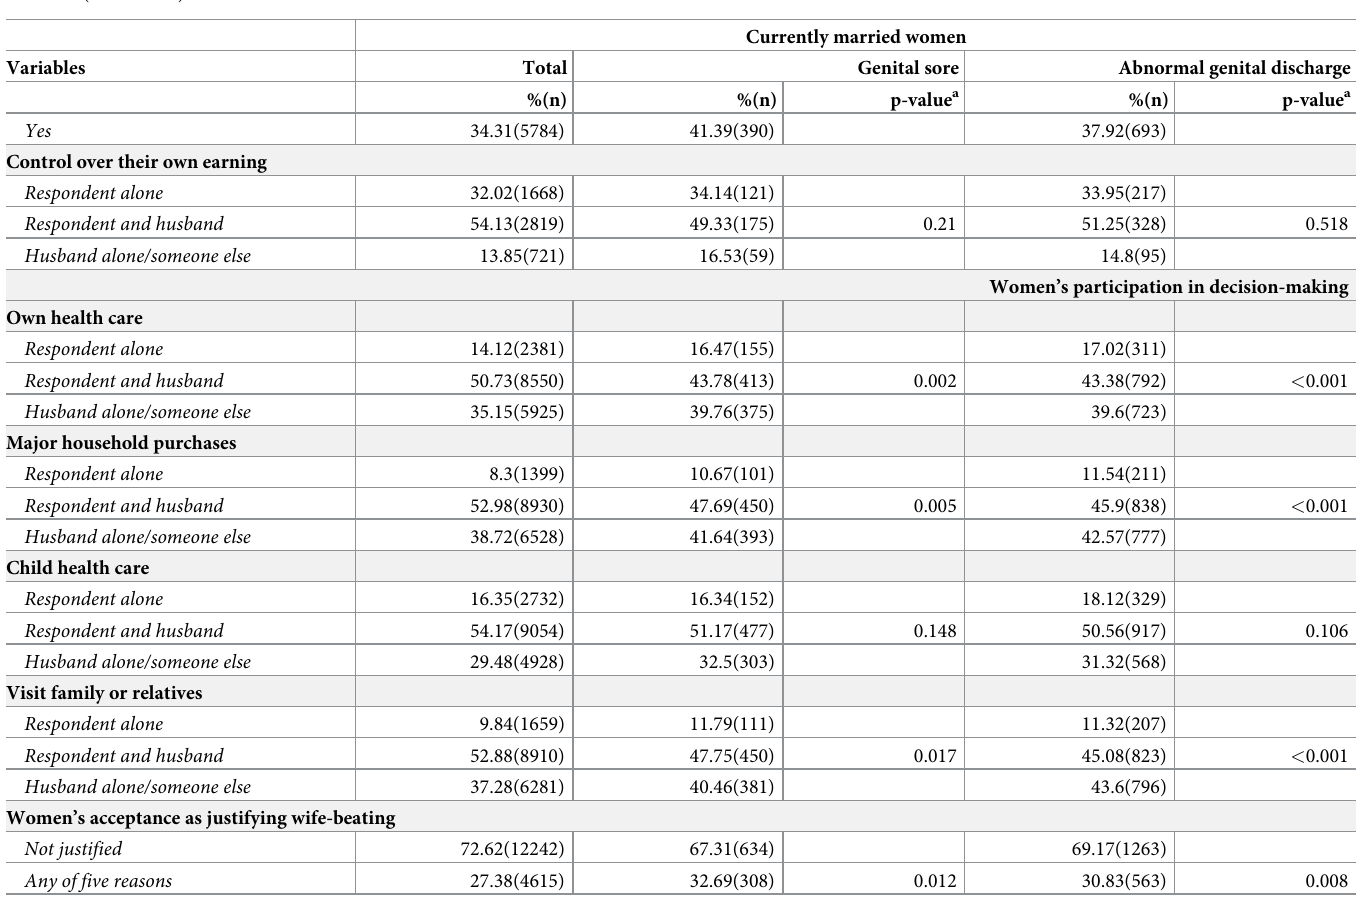
who reported abnormal genital discharge symptoms were 43.38%, 45.9% and 45.08%, respec- tively. 67% of women with symptoms of abnormal genital discharge agreed that wife-beating was not justified for any reason whereas, 67% of women who reported genital sores decided that wife-beating was not justified for any reason (Table 3).